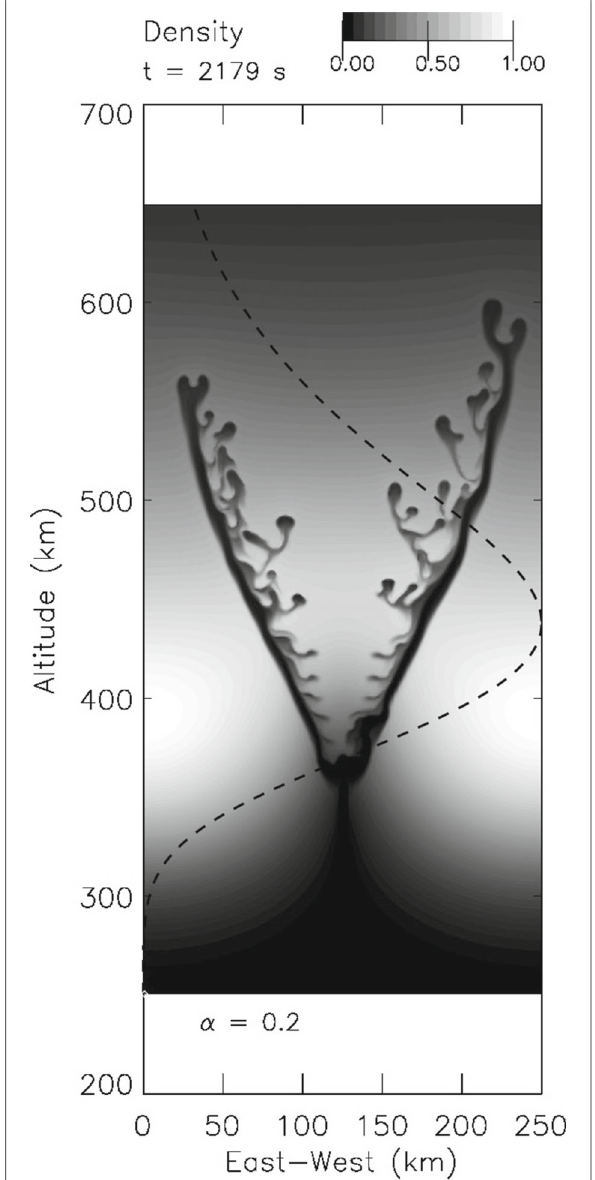
Fig. 4 Small-scale structures inside EPBs. The model here used an eighth-order spatial interpolation scheme and the partial donor cell method. Reproduced from Huba and Joyce (2007)